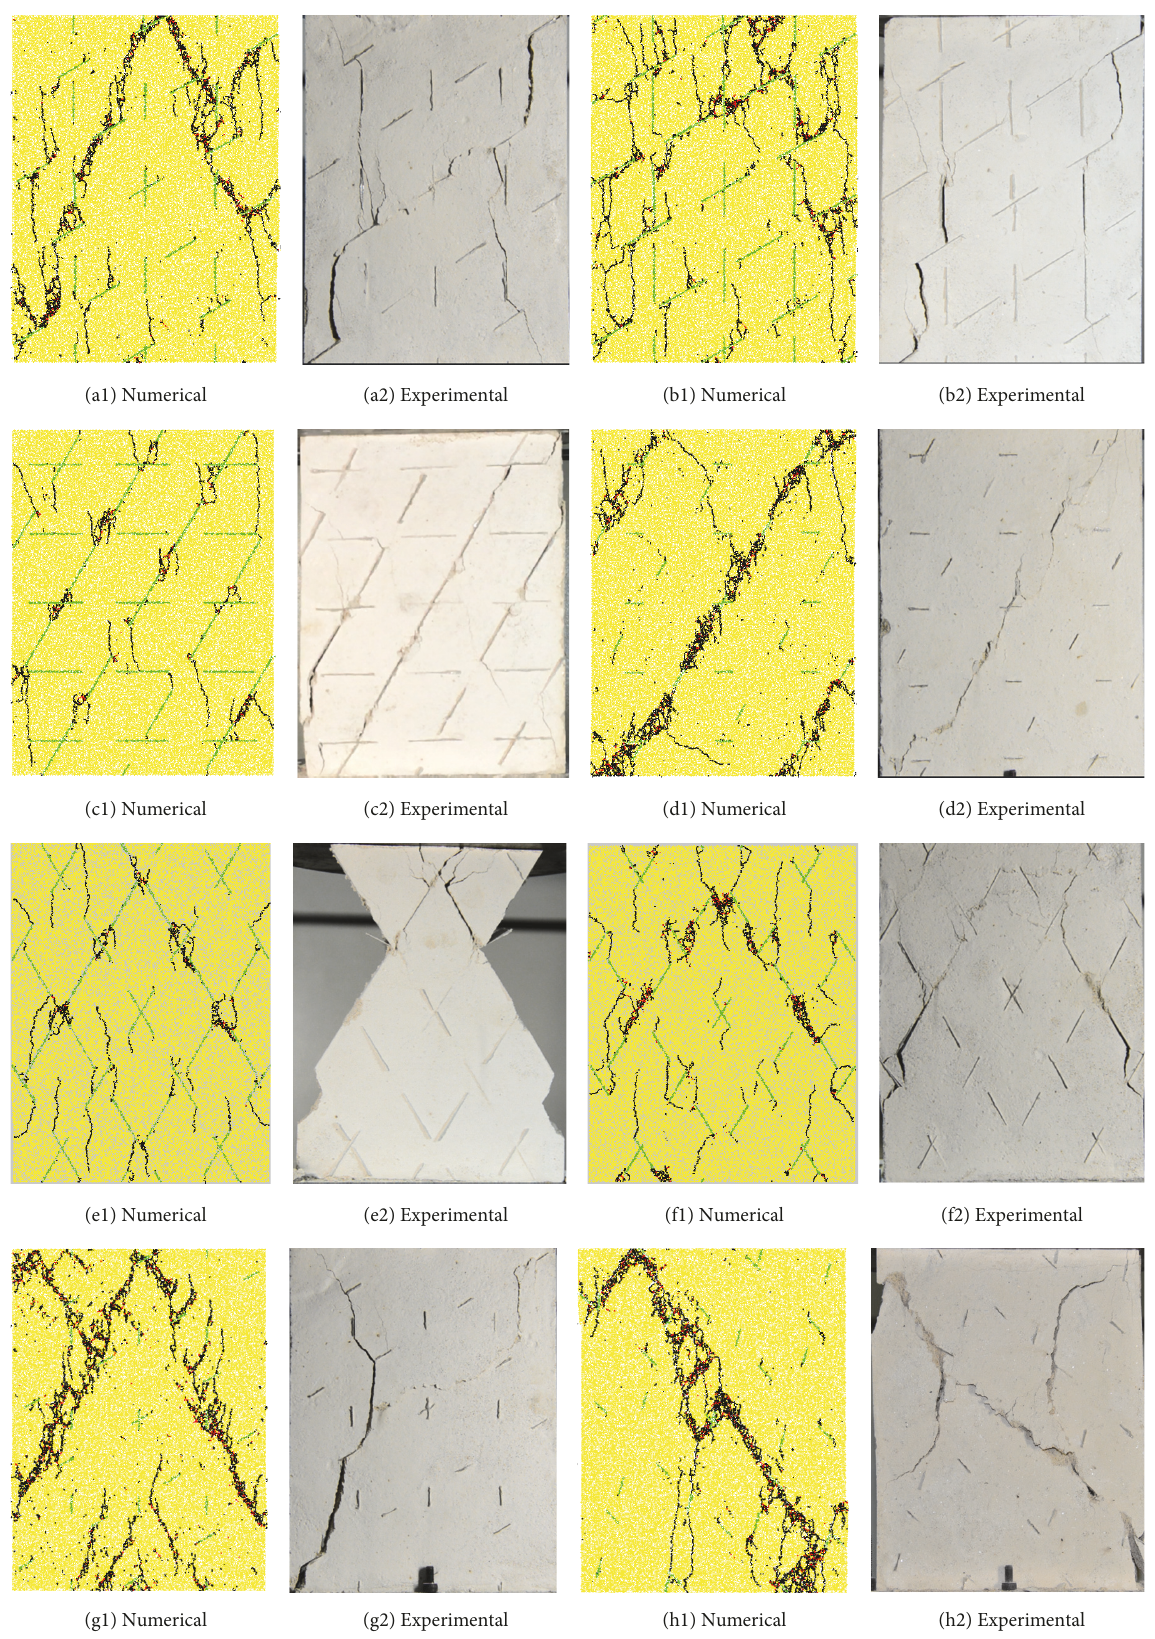
Figure 12: Failure mode comparisons between experimental and numerical results: (a) and (b) for stepped failure mode; (c) and (d) for failure through parallel plane; and (e) and (f) for failure through